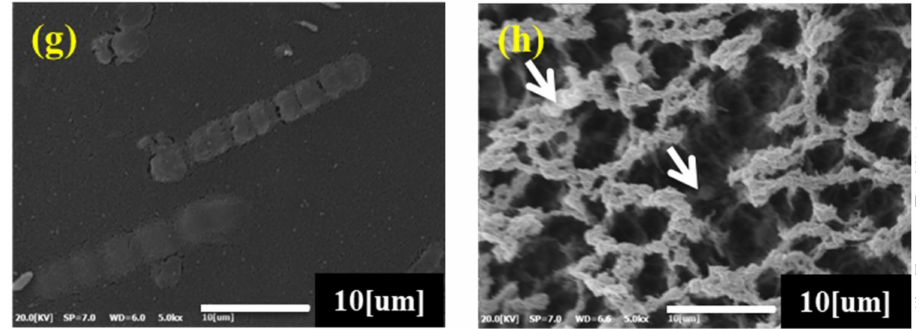
Figure 3. Scanning electron micrographs ( × 5000) of the raw materials, ( a ) Chlamydomonas angulosa , ( b ) Nostoc commune , ( c ) RC (surface), ( d ) RC (cross-section), and manufactured composites, ( e ) RCCA-5 (surface), ( f ) RCCA-5 (cross-section), ( g ) RCNC-5 (surface), and ( h ) RCNC-5 (cross-section).